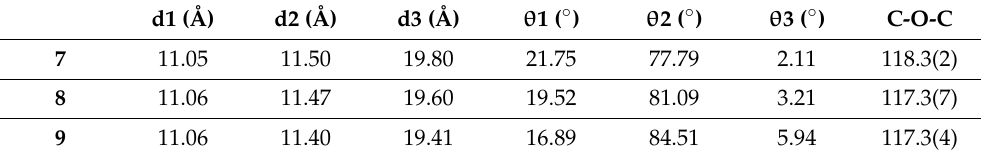
Table 3. Comparison of angles and distances for complexes 7 – 9 .